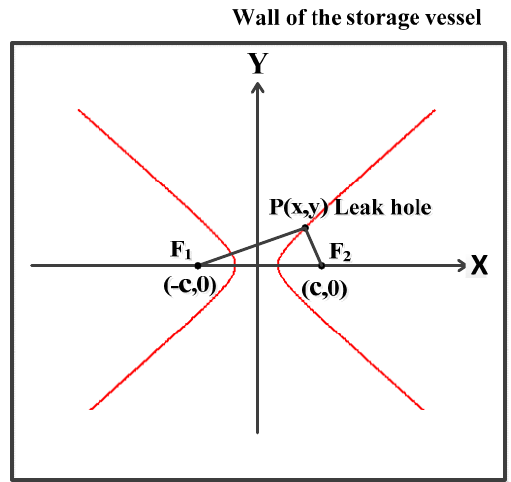
Figure 2. Principle of the localization.